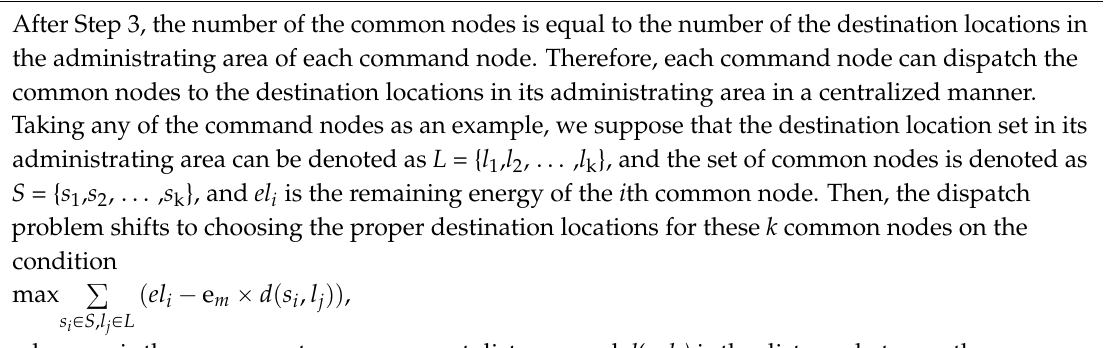
Algorithm 2. Dispatch process of dispatch